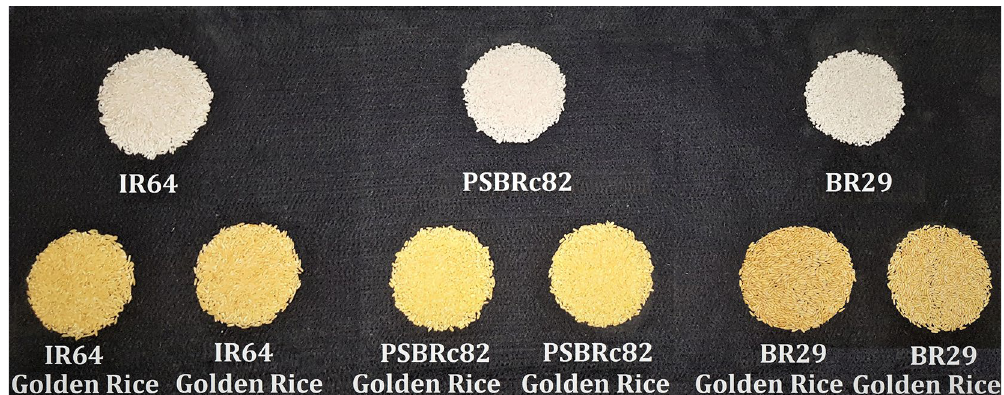
Figure 2. Grain samples of GR2E golden rice and respective recipient